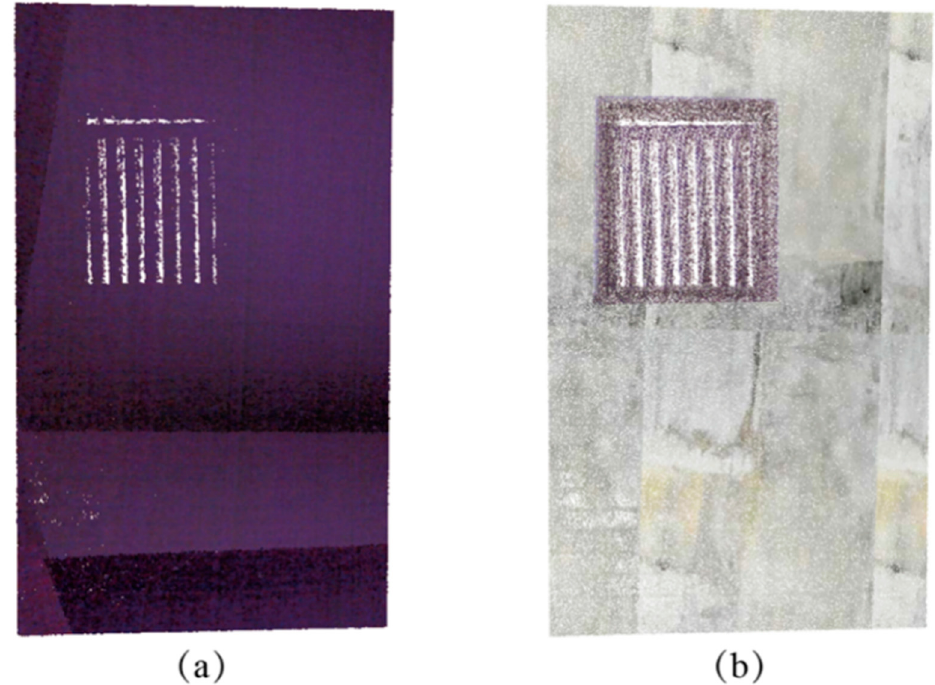
Figure 13. Point cloud of a wall with a window of the Zou Lu House: ( a ) the original registered point cloud; ( b ) registered point cloud after the proposed colorization method is applied.